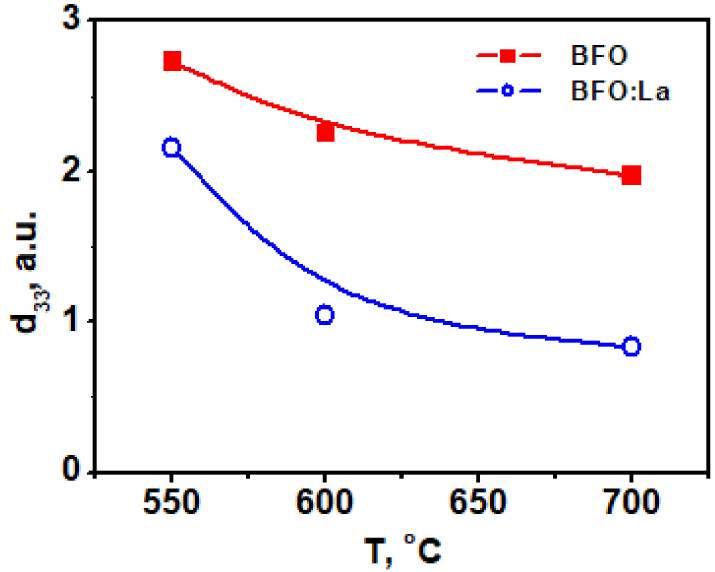
Figure 5. Evolution of the effective piezoresponse of BFO and BFO:La films annealed at different tem- peratures.